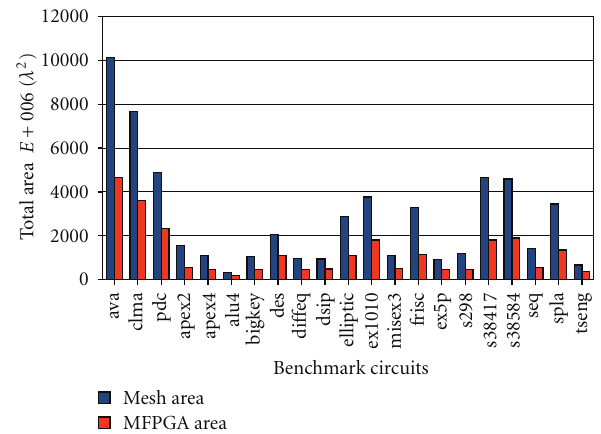
Figure 13: MFPGA area versus Mesh area (21 benchmark circuits).